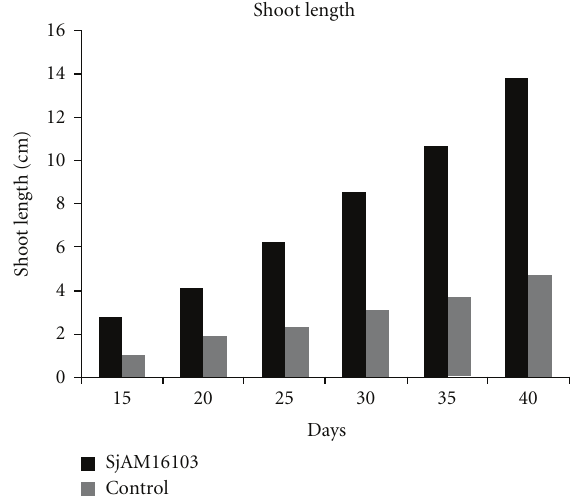
Figure 7: Inoculation of endophytic S. aquimarina SjAM16103 in E . agallocha.